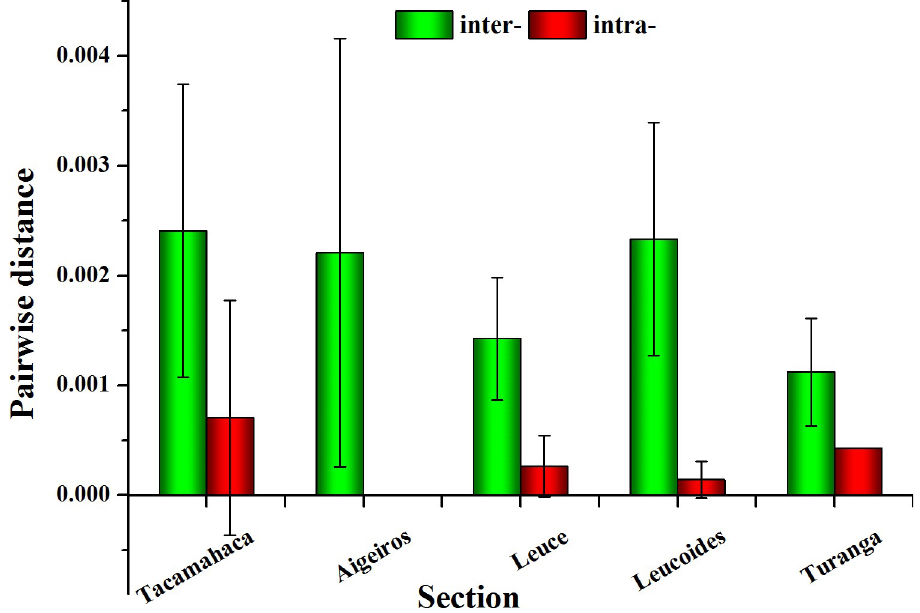
Fig 1. Average inter- and intraspecific pairwise distances for each section using the chloroplast combination data.